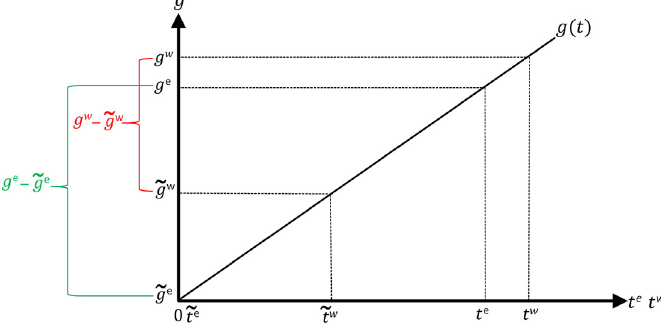
Figure A1 Impact on